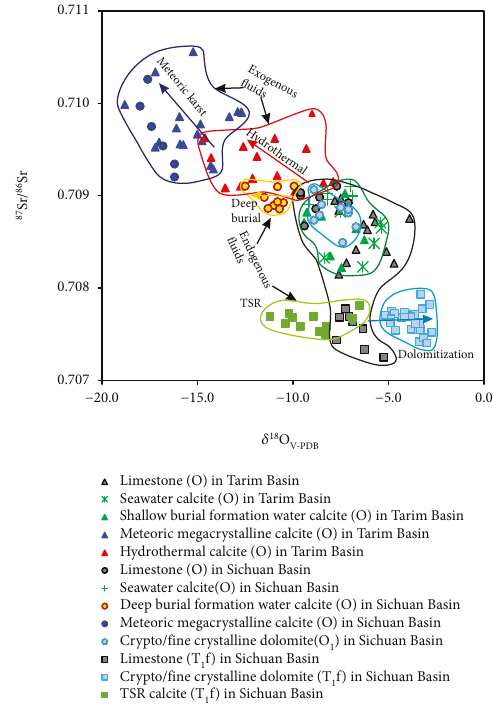
Figure 5: Strontium and oxygen isotope compositions to identify di ff erent fl uid alterations in the deep marine carbonate reservoirs.